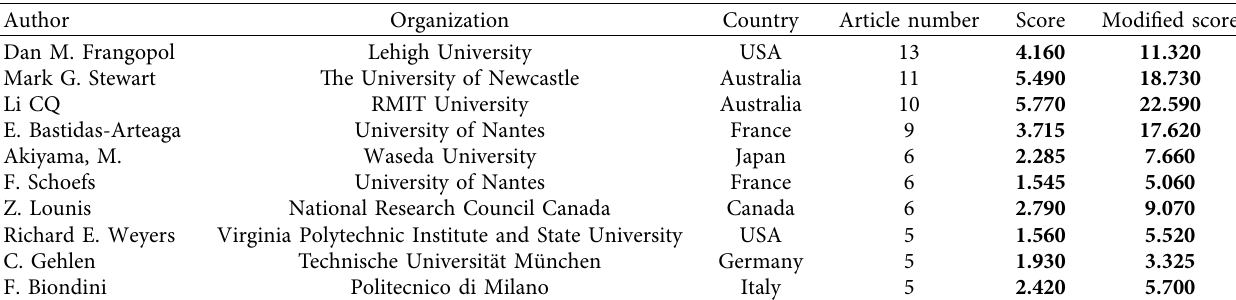
Table 4: Authors’ contribution score and modified score in this research